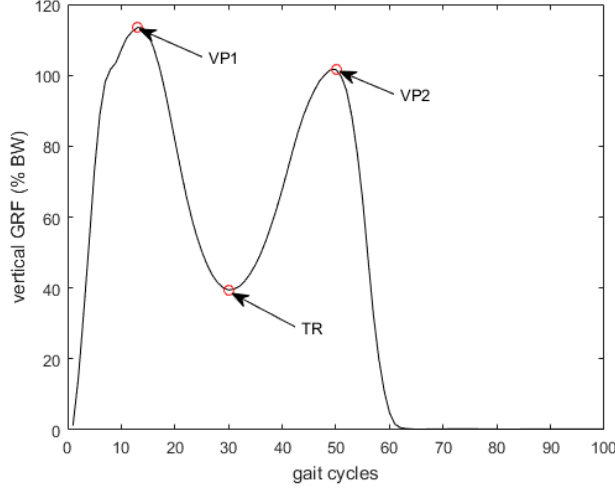
Figure 3. Illustration of the ground reaction force vertical peaks (VP1 and VP2) and trough (TR). Table 2. Mean and SD of the prediction errors for OCW (rRMSE %) based on fifth lumbar vertebra (L5) acceleration.